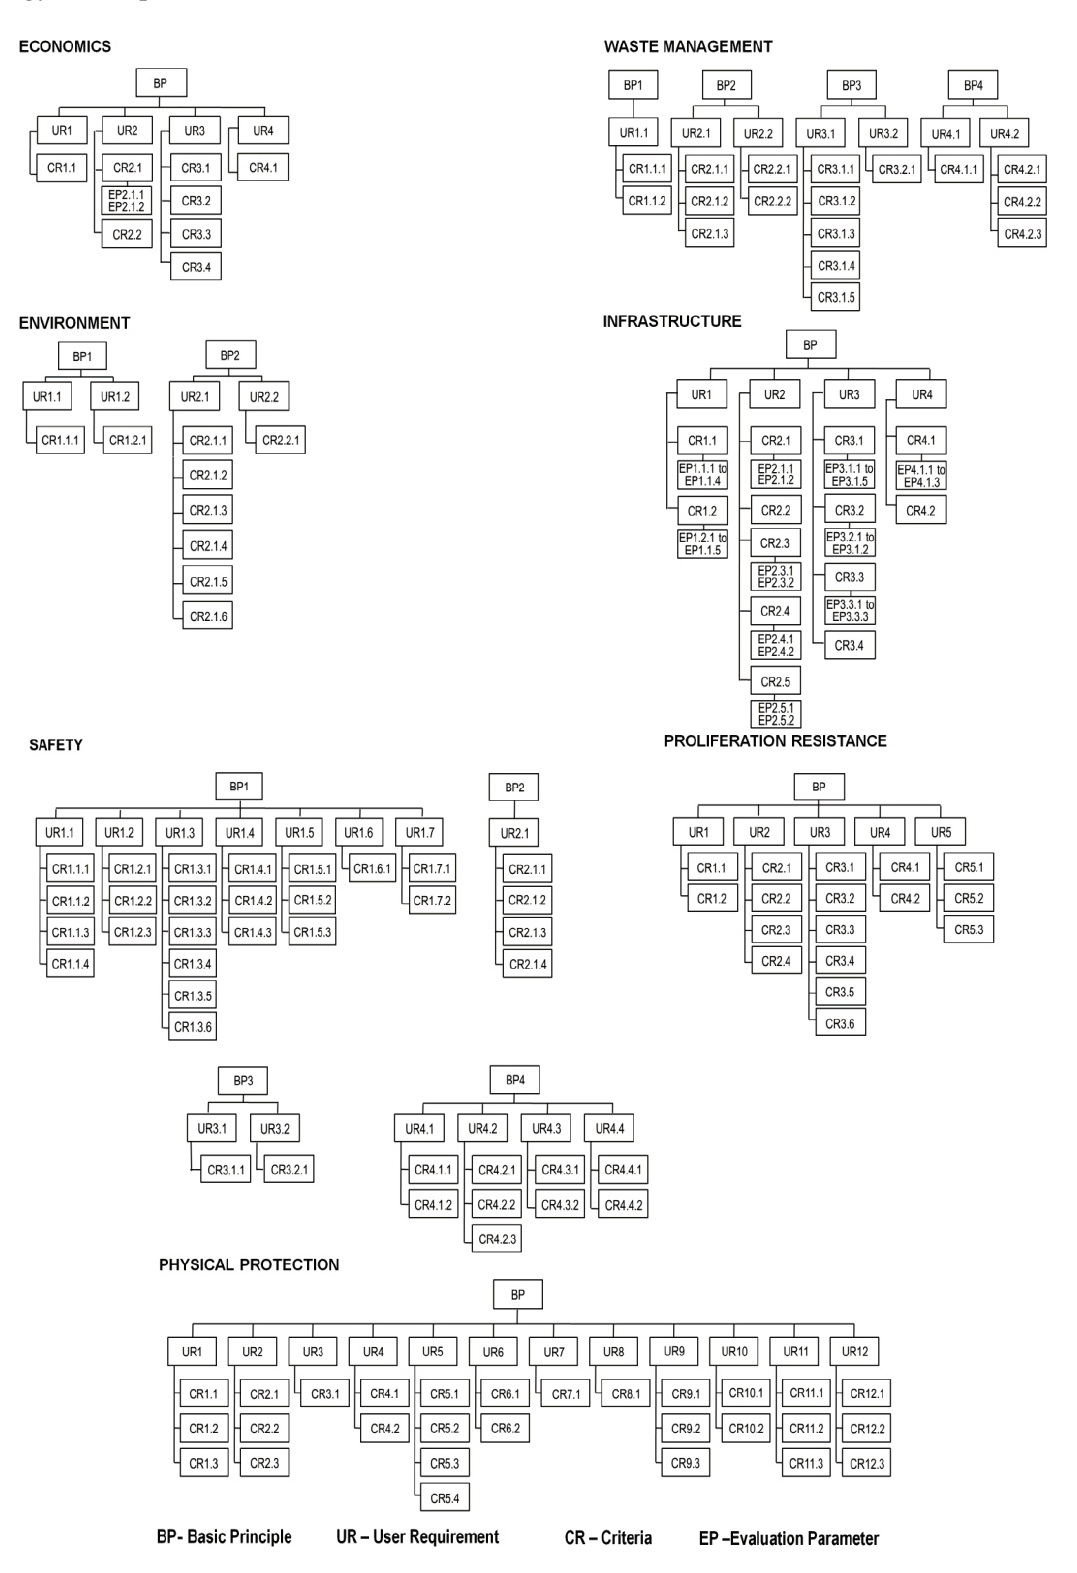
Figure 2. The INPRO hierarchies for each